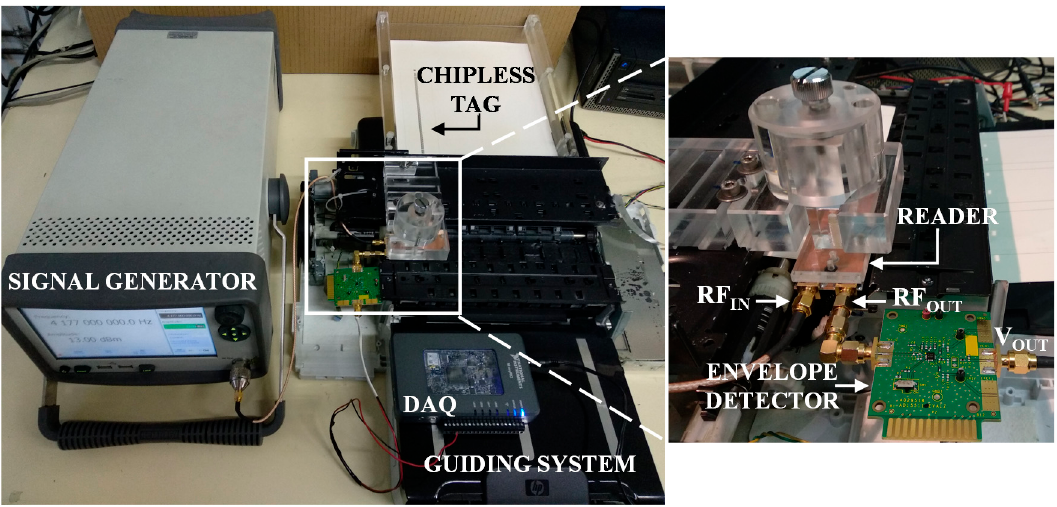
Figure 4. Photograph of the reader.